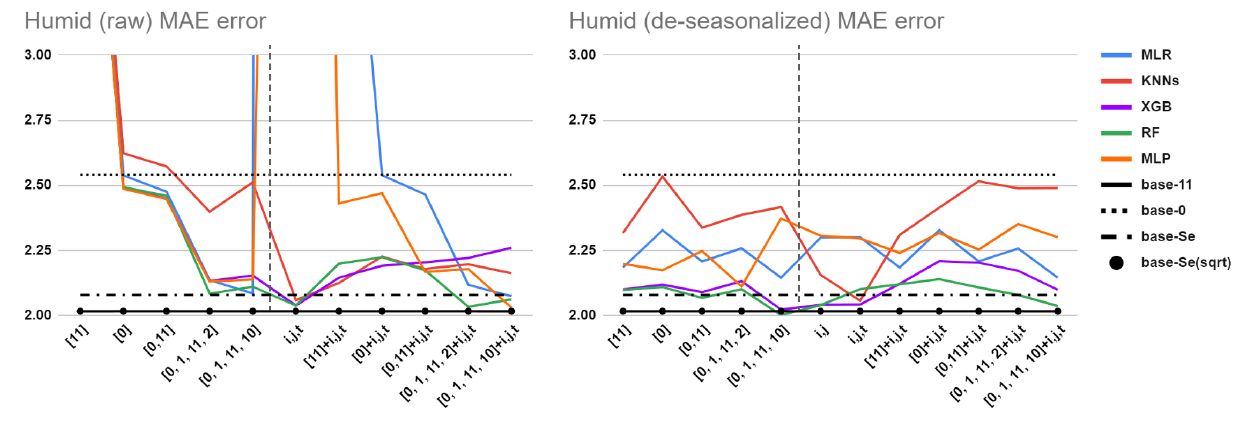
Figure 9. MAE for humidity predictions with different feature sets, for raw and de-seasonalized data